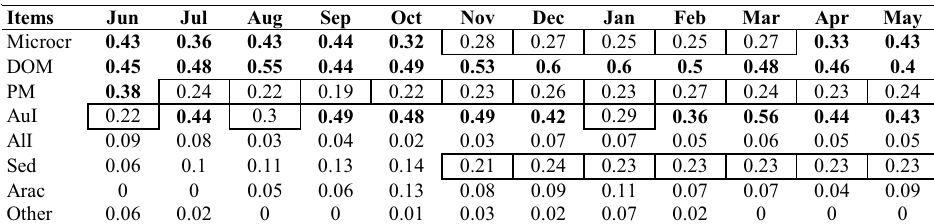
Table 3. Index of alimentary importance for E. trilineata adult food categories. Bold numbers = main item; framed numbers = addition item; simple numbers = accidental item.